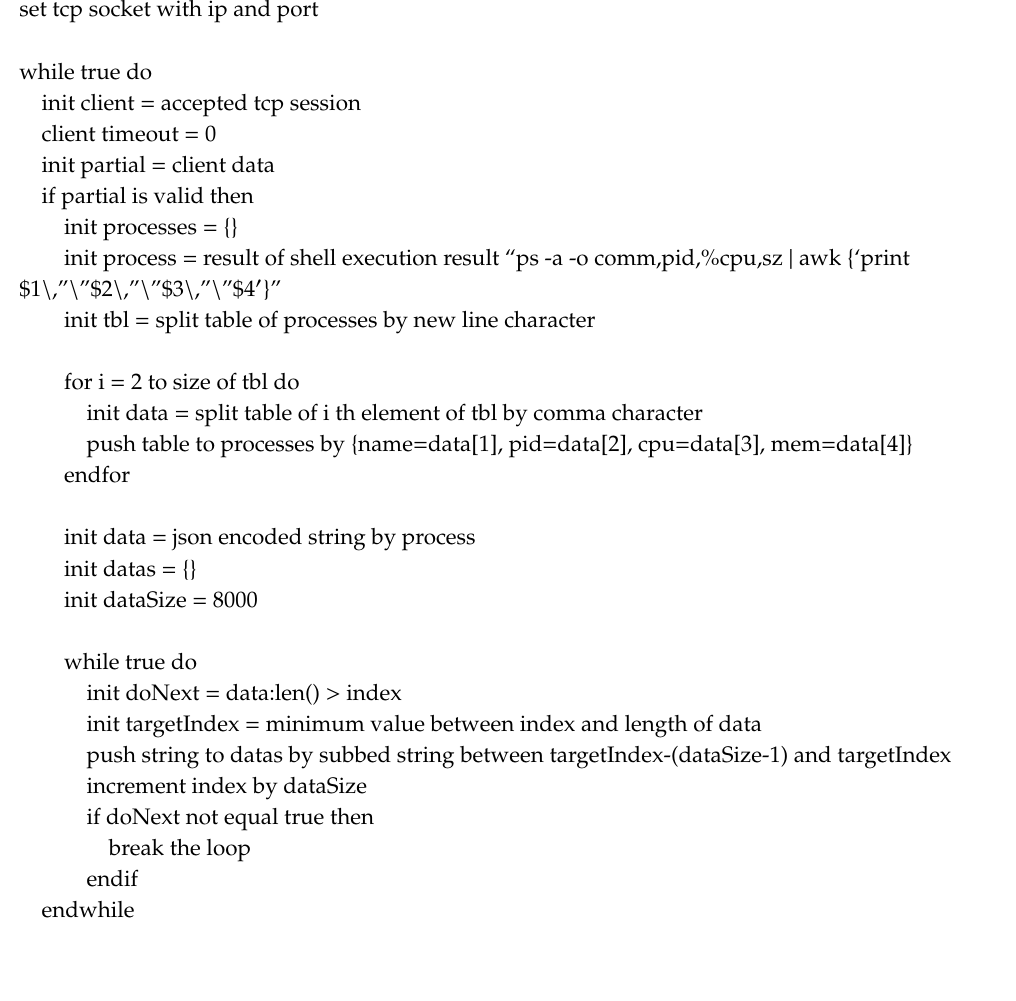
Algorithm 1. Pseudo code for the communication module of the GWRMS daemon